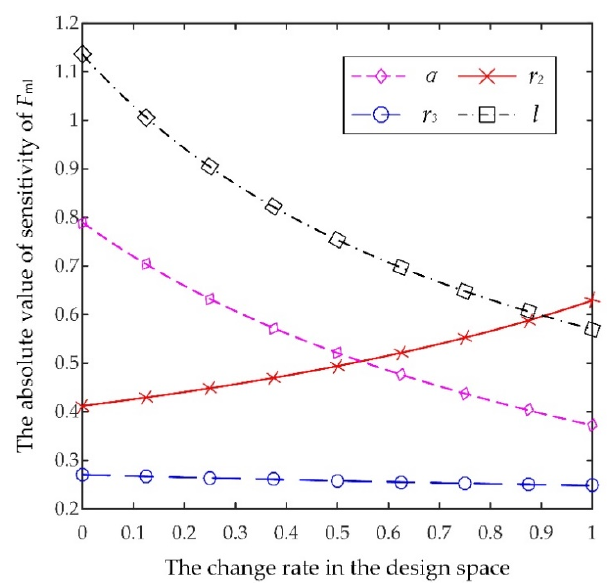
Figure 12. The absolute value of the sensitivities of F ml with regard to the change rate of variables in the design space.